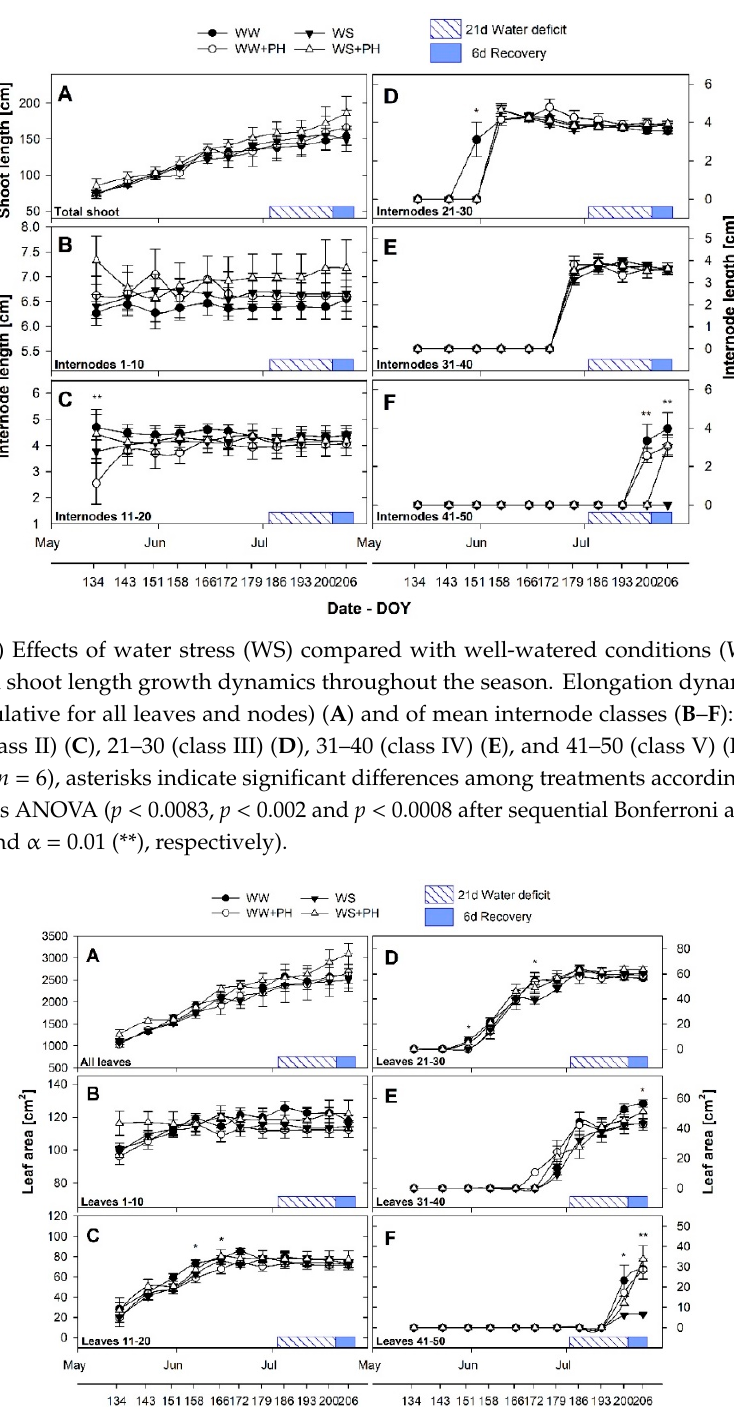
Figure 4. ( A ) E ff ects of water stress (WS) compared with well-watered conditions (WW) and PH application, on primary shoot leaf area growth dynamics throughout the season. Dynamics of growth in cumulative leaf area of shoots ( A ) and in mean leaf area classes ( B – F ): 1–10 (class I) ( B ), 11–20 (class II) ( C 21–30 (class III) ( D ), 31–40 (class IV) ( E ), and 41–50 (class V) ( F ). Values are means ± SE ( n = 6), asterisks indicate significant di ff erences among treatments according to repeated measurements ANOVA ( p < 0.0083, p < 0.002 and p < 0.0008 after sequential Bonferroni adjustment for α = 0.05 (*) and α = 0.01 (**),